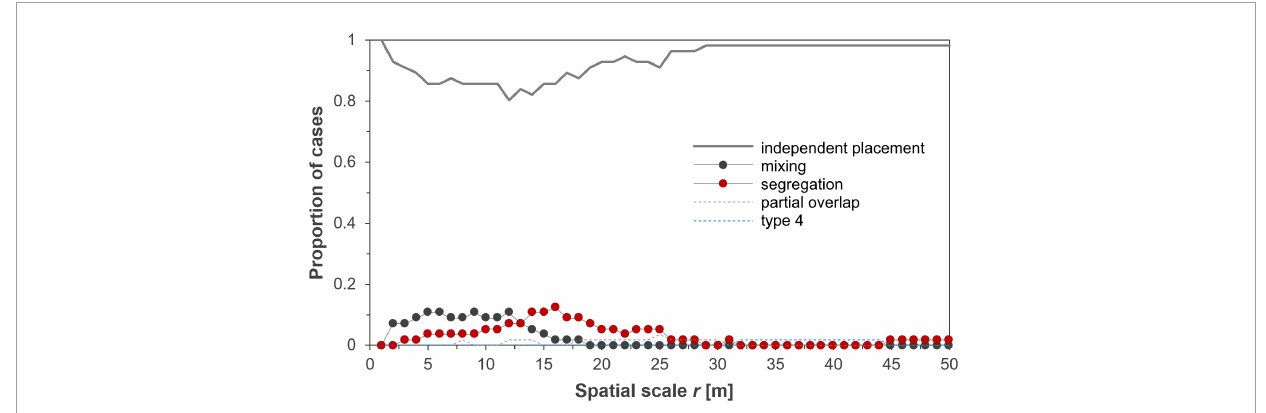
FIGURE2 Changes in the network of spatial association patterns among the 8 dominant species in dependence on spatial scale. Shown is the proportion of the 56 species pairs that were categorized into one of the five spatial association types at a given spatial scale r . The gray line indicates the independence type; red solid circles segregation (type 1); black solid circles mixing (type 3); the dashed gray line indicates partial overlap (type 2); and the dashed blue line type